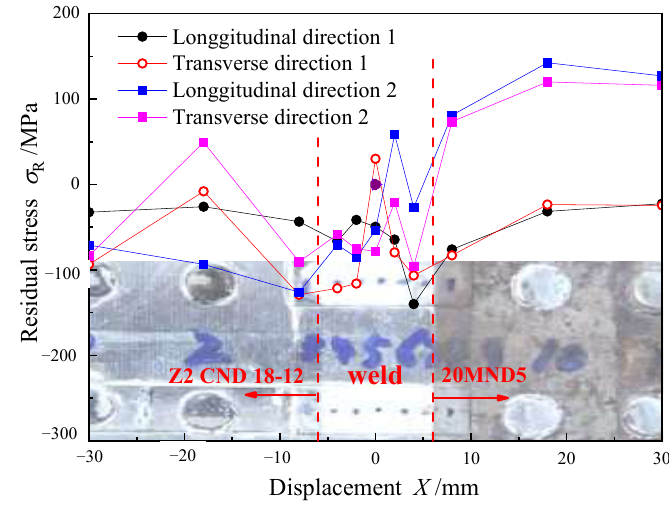
Figure 12. Location of residual stress measuring points on the outer wall of the test block. Figure 12. The residual stress measuring